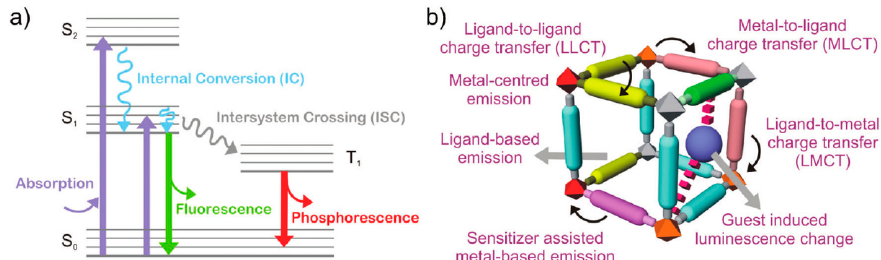
Figure 1. ( a ) Partial energy-level diagram for photoluminescent processes; ( b ) various possibilities for the emission of metal–organic frameworks (MOFs). Reproduced with permission from [24]. Copyright the Royal Society of Chemistry, 2017.